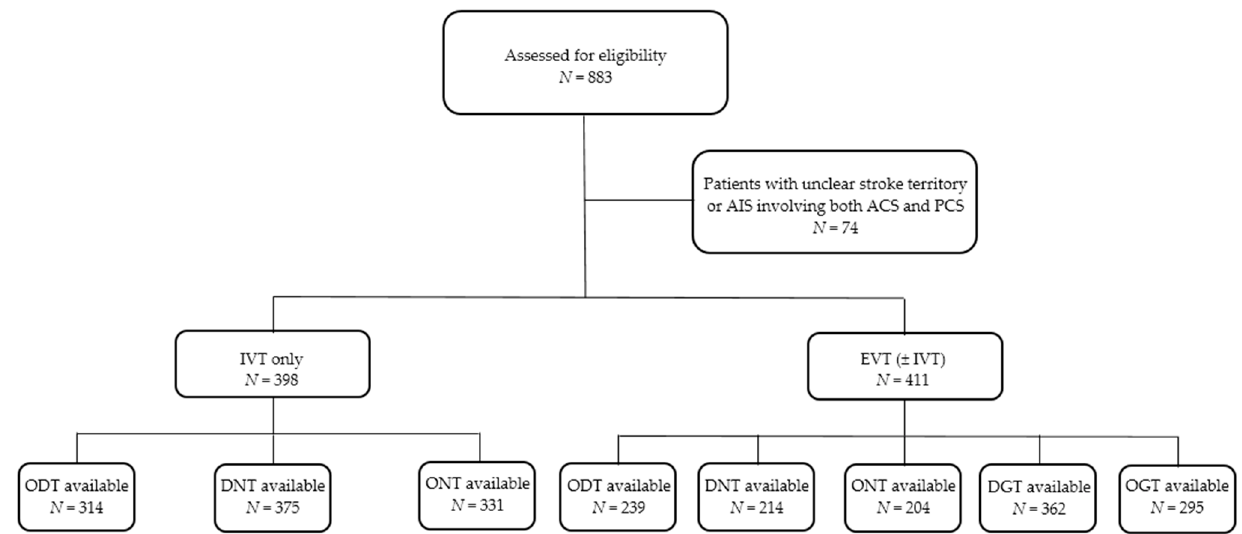
Figure 1. Flowchart of the study. ACS, anterior circulation stroke; AIS, acute ischemic stroke; DGT, door-to-groin puncture time; DNT, door-to-needle time; EVT, endovascular therapy; IVT, intravenous thrombolysis; N , Number; ODT, onset-to-door time; OGT, onset-to-groin time; ONT, onset-to-needle time; PCS, posterior circulation stroke.